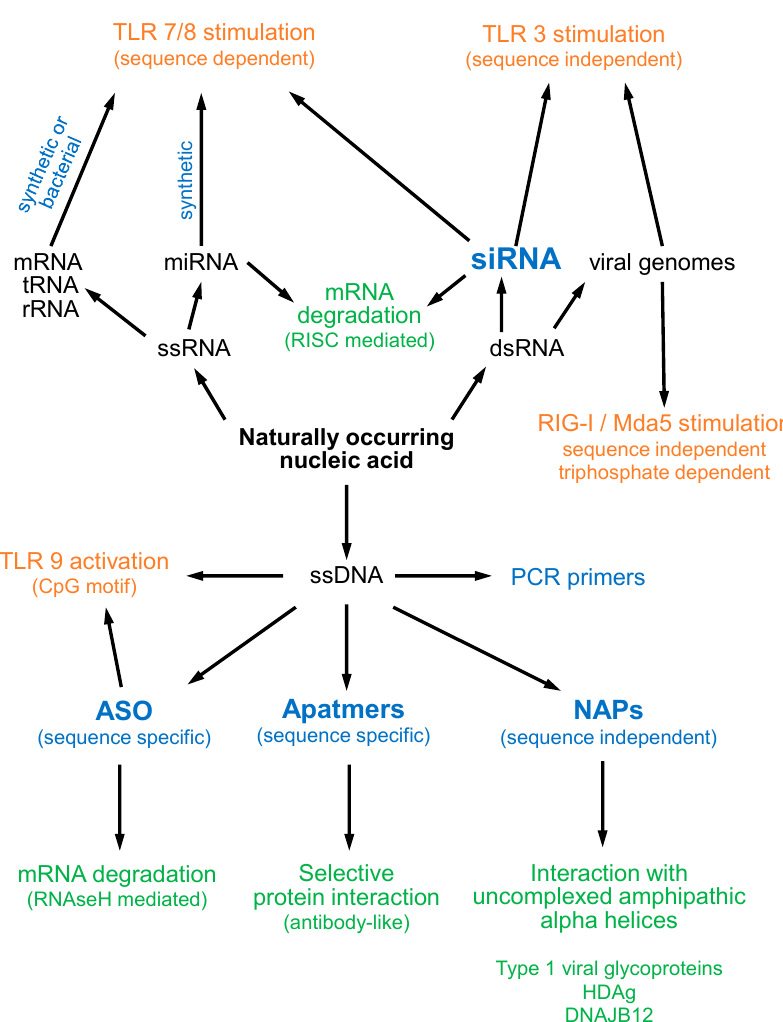
Figure 1. Relationships between known oligonucleotide classes and their pharmacological activities. Synthetic oligonucleotides are indicated in blue with therapeutic activity in bold. Non-immune pharmacological effects are indicated in green. Immunostimulatory effects are indicated in orange.